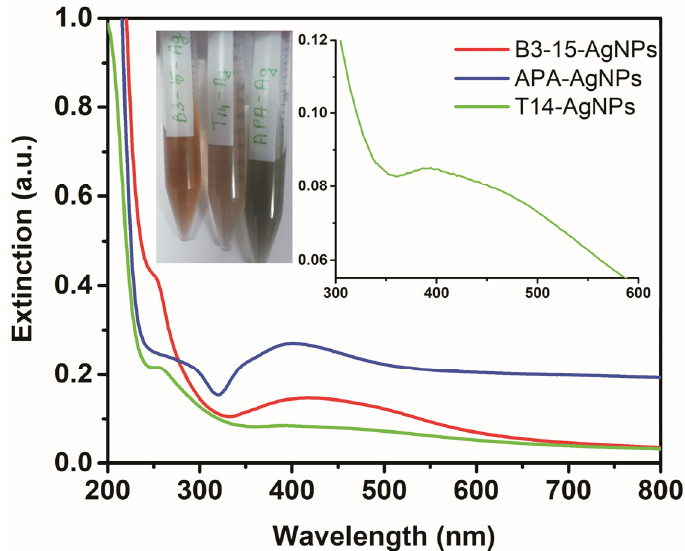
Figure 2. Extinction spectra of EPS B3-15-Ag NPs (red), γ -PGA-APA-Ag NPs (blue) and EPS T14- Ag NPs (green), with photographs of the three samples. The inset reports a magnification of the band at 394 nm of EPS T14-Ag NPs .